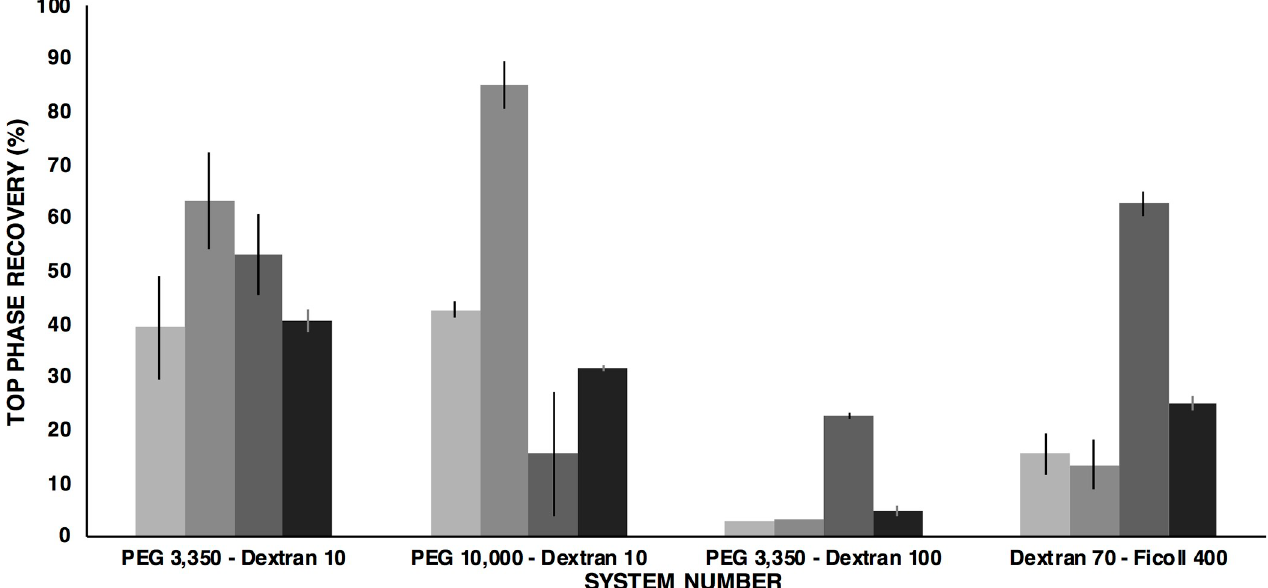
Fig 3. Effect of NaCl upon top phase recovery yield of exosomes and contaminants in the selected systems. The height of each bar represents the top phase recovery percentages for exosomes ( ■ ) and contaminants ( ■ ) under initial conditions, and after 25 mmol L -1 NaCl addition ( ■ ) and ( ■ ), respectively.